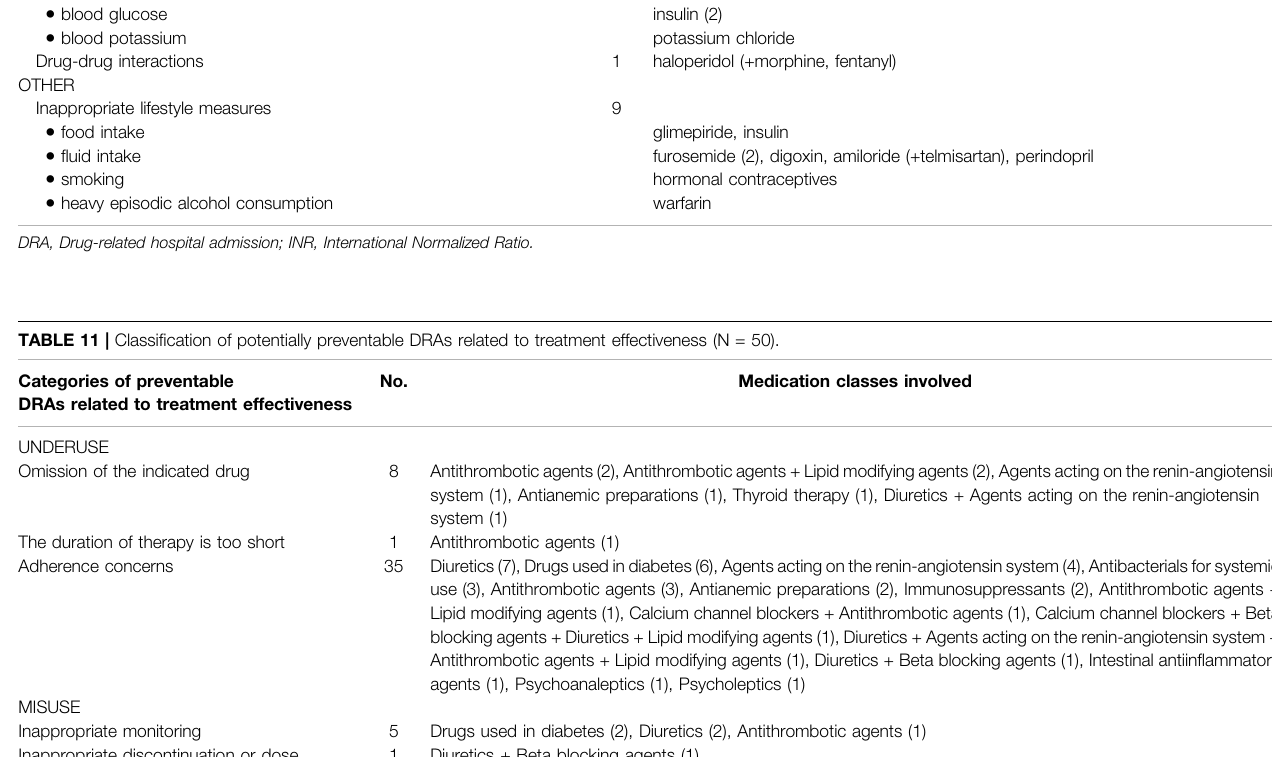
TABLE 10 | Classi fi cation of potentially preventable DRAs related to treatment safety (N = 50). Categories of preventable DRAs related to treatment safety OVERUSE Drug without an indication